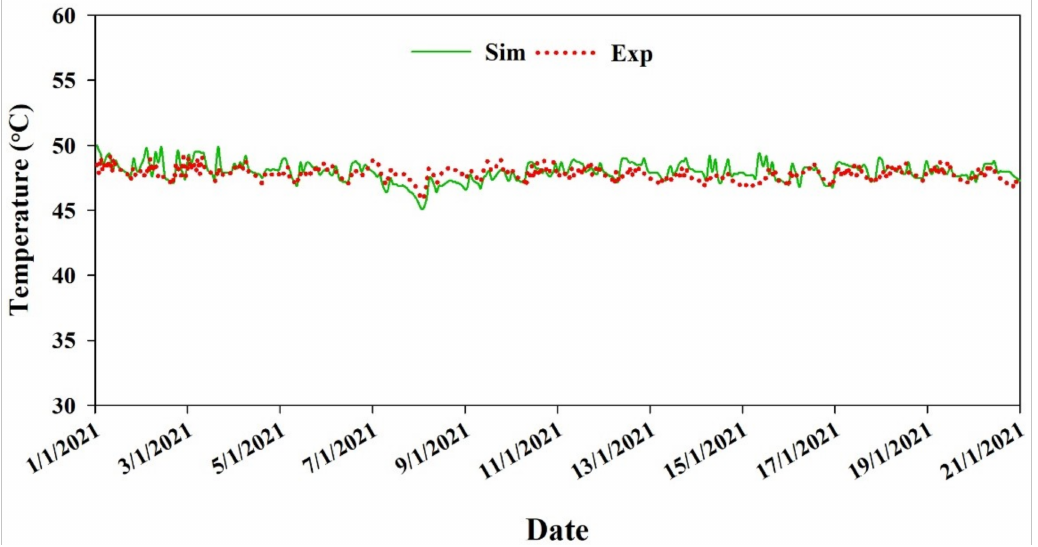
Figure 16. Water storage tank temperature